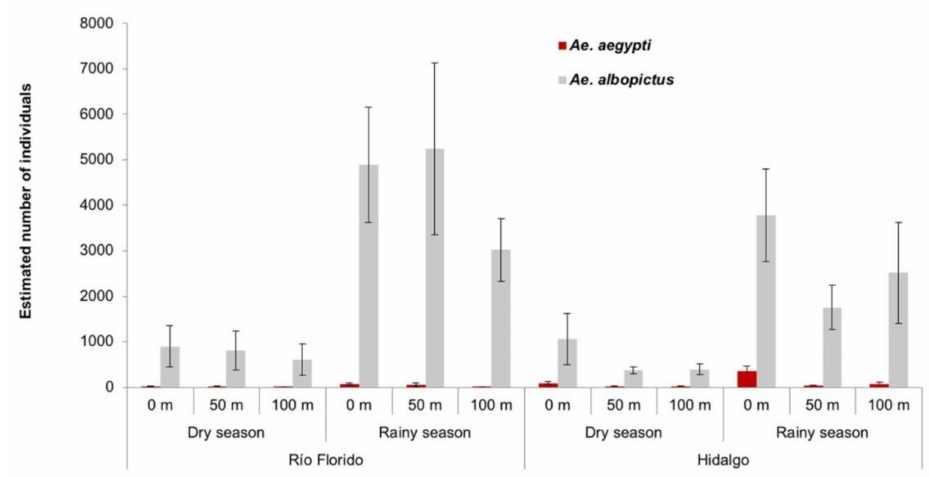
Figure 5. Mean (+SE) estimated abundance of Aedes aegypti and Ae. albopictus in the zones surrounding R í o Florido and Hidalgo villages in the dry and rainy seasons during a three-year study. The estimated abundance is the product of number of eggs per location of ovitrap in transect by season and the proportion of each species present in laboratory-reared